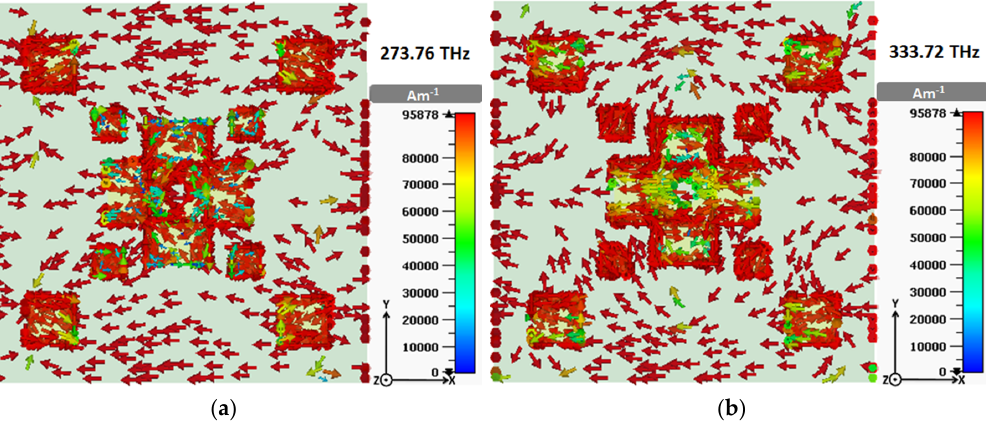
Figure 10. Surface current distribution of the metallic layer at ( a ) 273.76 THz and ( b ) 333.72 THz.